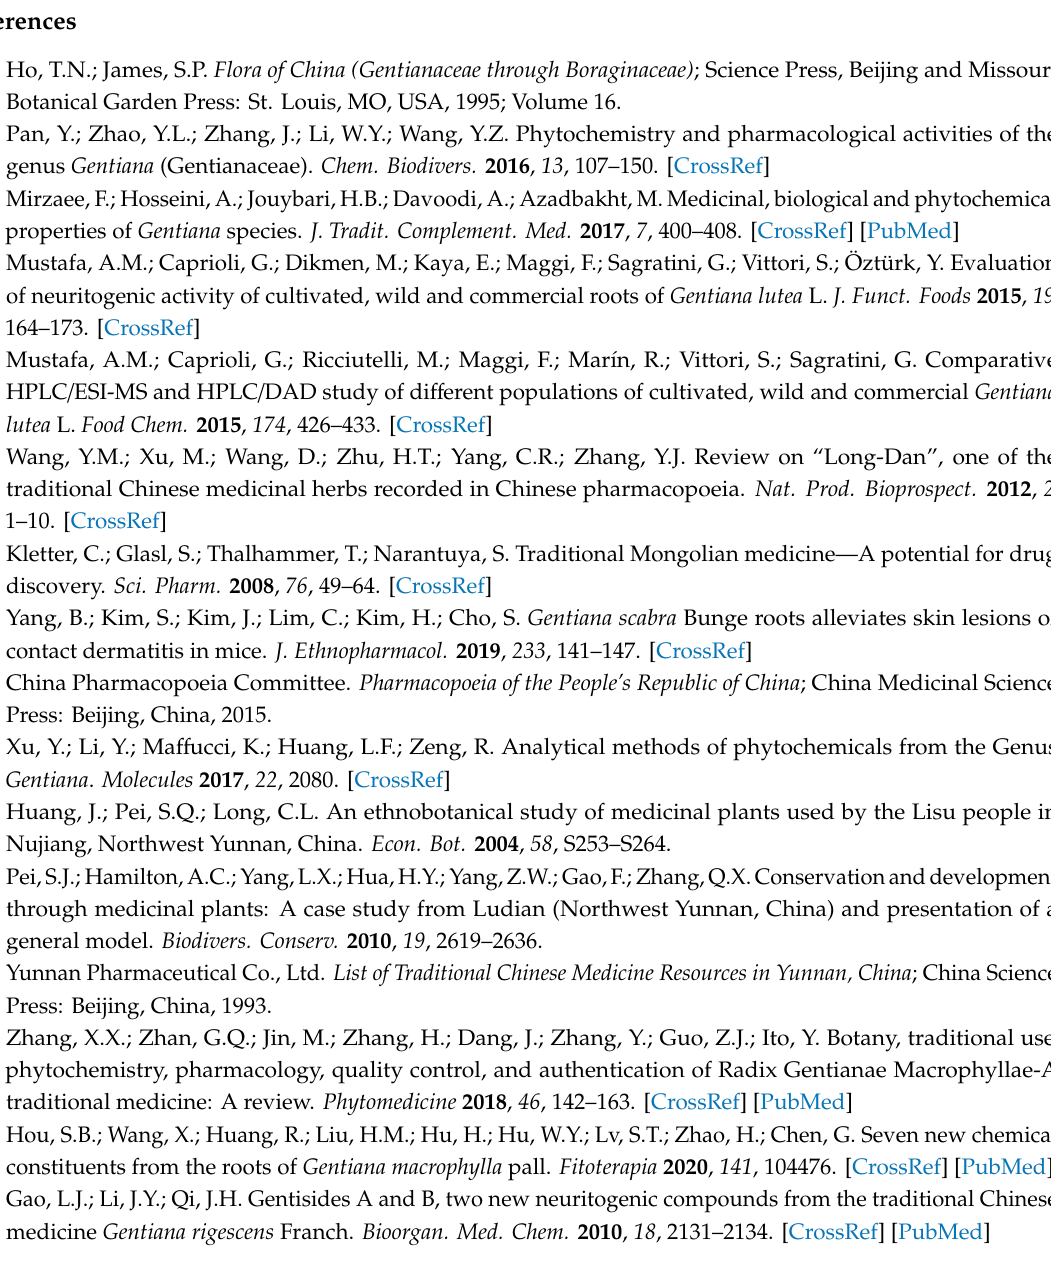
Table S47. Confusion matrixes of the calibration set and validation set of Mid-SVM, Table S48. Confusion matrixes of the calibration set and validation set of